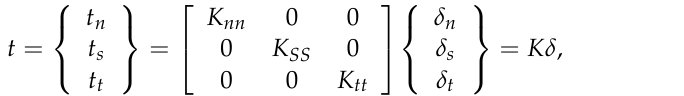
Figure 5. The response of the interface phase linear elastic separation under normal loading.